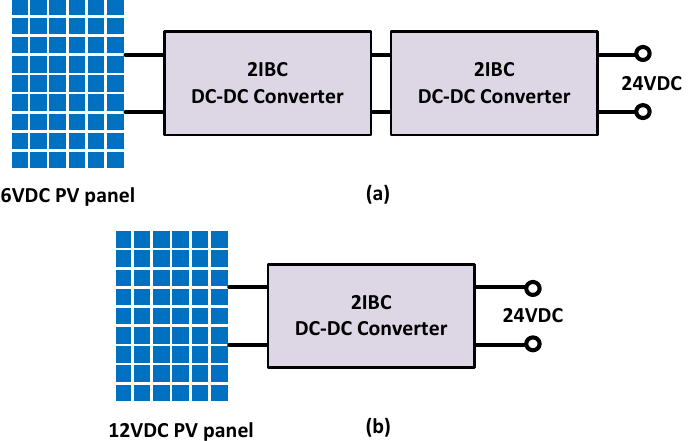
Figure 5. How to provide 24 VDC with the modular converter: ( a ) with the 6 VDC PV panel; and ( b ) with the 12 VDC PV panel.